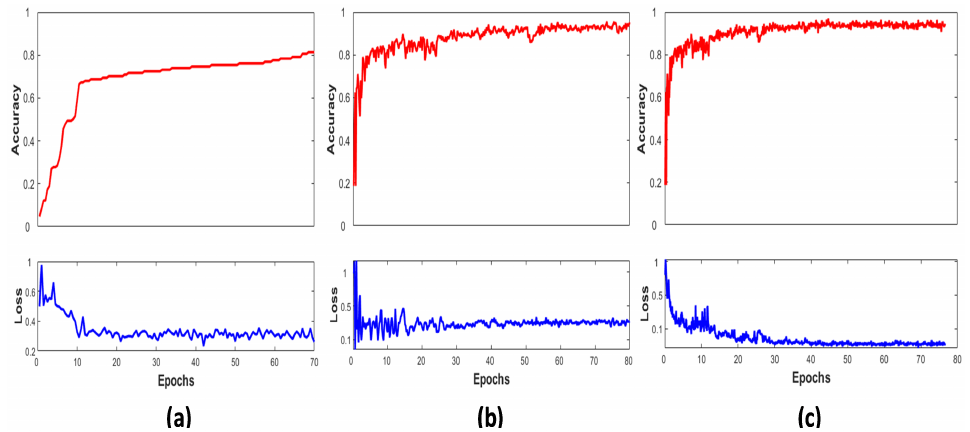
Figure 4. Classification accuracy and loss curves of the LCNet with the number of epochs on the validation set ( a ) MEL vs. BEN lesion classes ISIC 2016, ( b ) MEL vs. SK and NV lesion classes ISIC 2017, and ( c ) MEL vs. BEN lesion classes ISIC